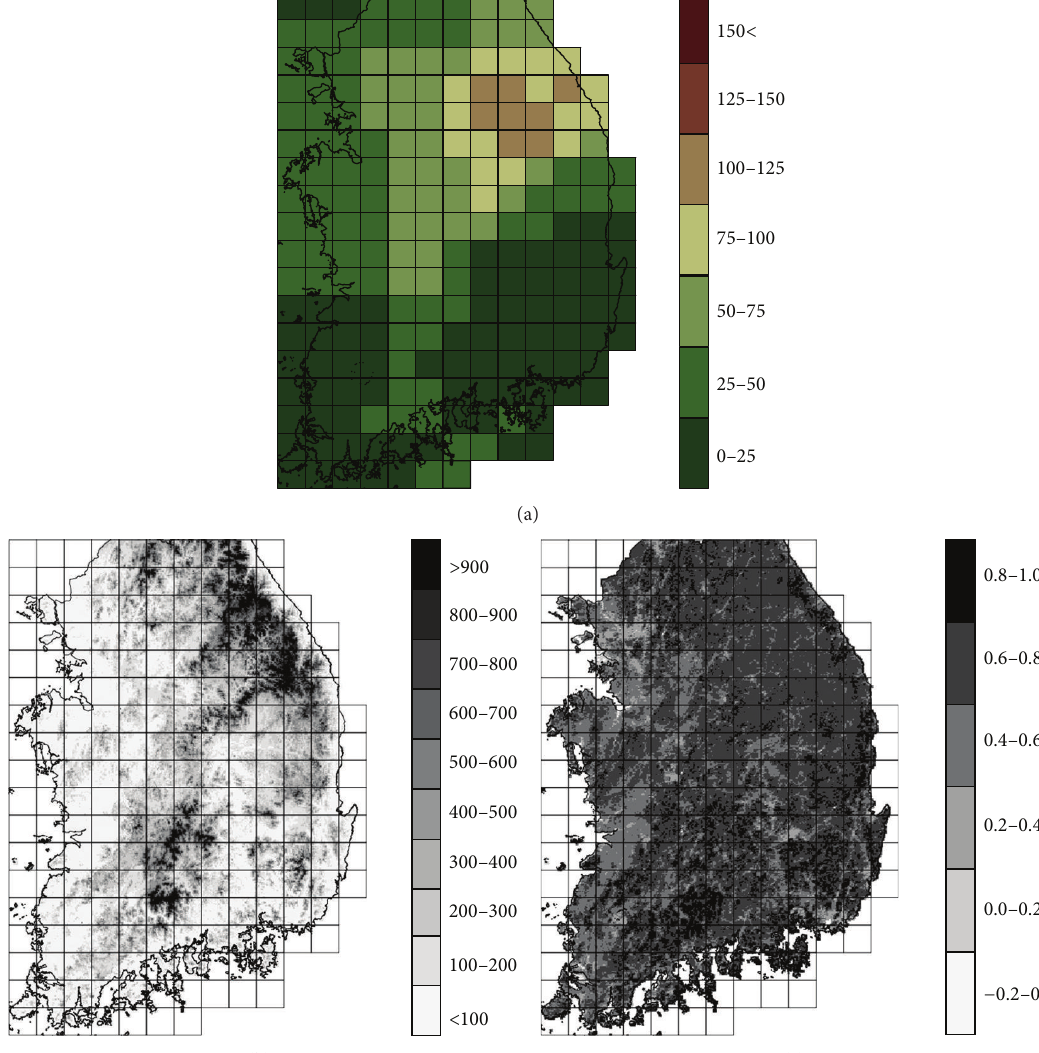
Figure 1: Data sets used for the downscaling experiment: (a) TRMM precipitation data (unit: mm), (b) DEM (unit: m), and (c) NDVI. The rectangles denote TRMM blocks and the size of each block is 25 km by 25